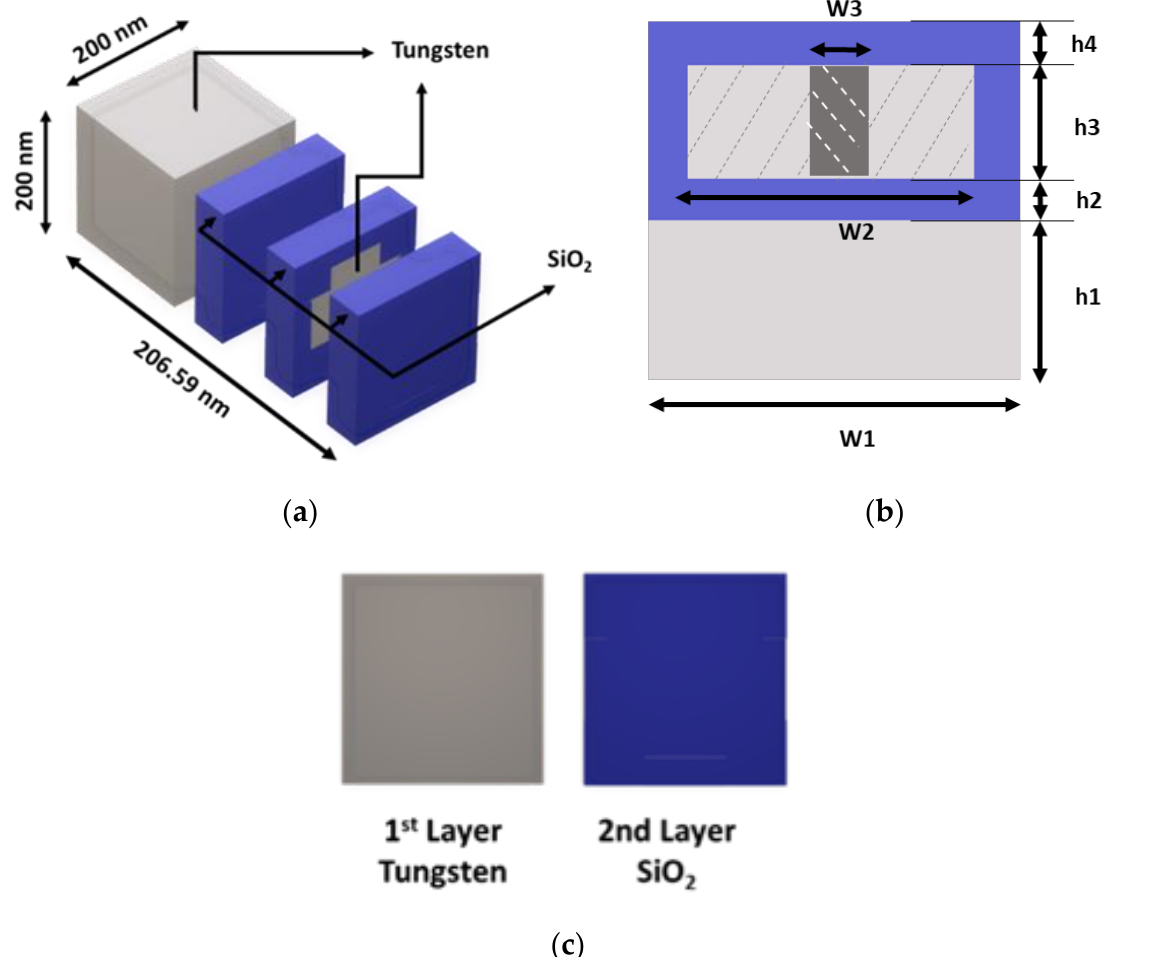
Figure 1. The design of the unit cell ( a ) perspective view ( b ) cross-section ( c ) internal structure and layer constituents.